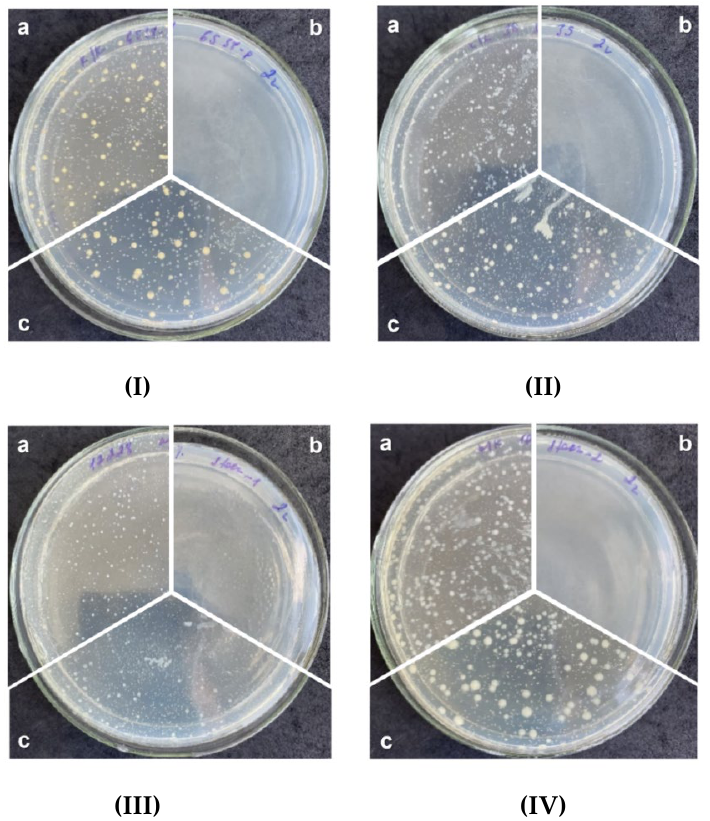
Figure 7. The results of antimicrobial activity testing of composites against S. aureus 6538-P ( I ), S. aureus 39 ( II ), S. epidermidis 12228 ( III ), and Kl. pneumoniae 10031 ( IV ): a—negative control; b—Polymer composite with 5 wt.%-Triclosan; c—polymer composite.